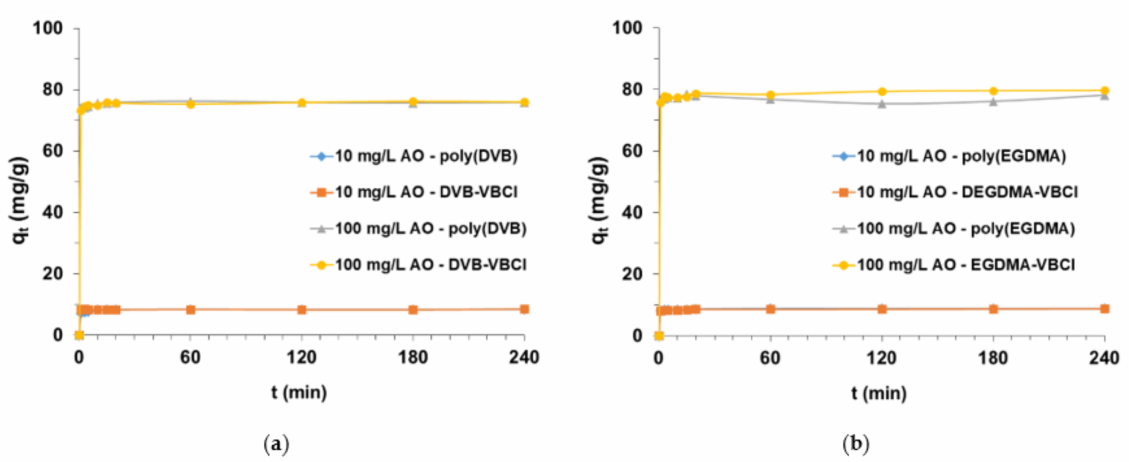
Figure 8. Time impact on AO uptake from the solutions of initial concentrations 10 mg/L and 100 mg/L by ( a ) poly(DVB) and DVB-VBCl as well as ( b ) poly(EGDMA) and